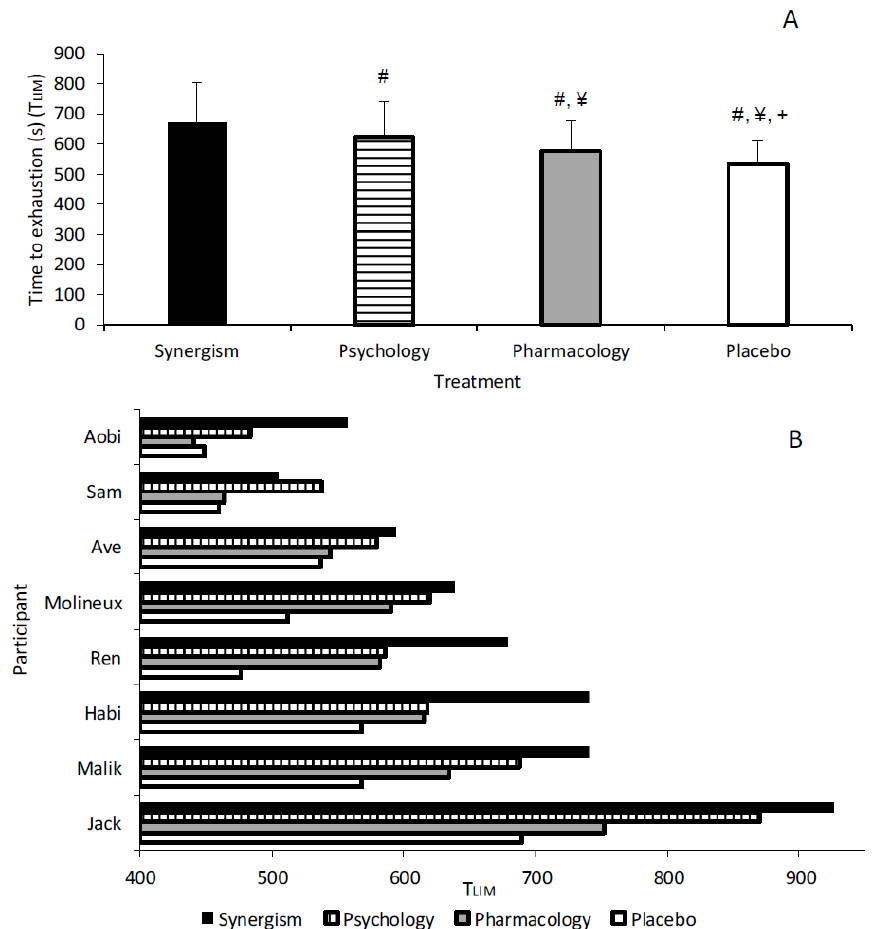
Figure 2. Endurance capacity (TLIM) scores (s). ( A ) Mean T LIM (s) across treatments (#, ¥ and + denotes significantly lower vs. synergism, psychology and pharmacology, respectively); ( B ) subjective T LIM across treatments.